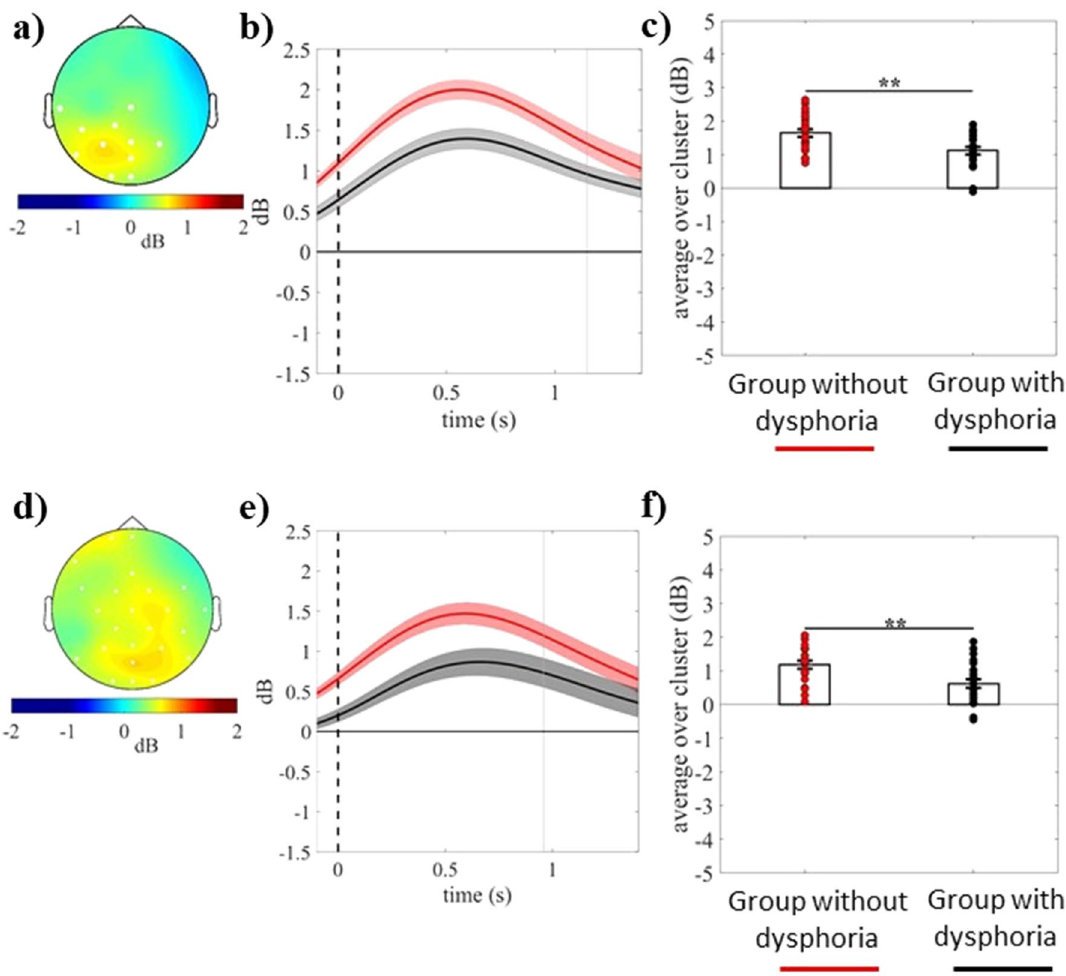
Figure 3. ( a , d ) Topography of the mean difference between groups in event-related delta power (dB; group without dysphoria minus group with dysphoria) averaged over the significant time points ( a ; − 100 to1148 ms time window) for the pleasant and ( d ; − 100 to 958 ms time window) neutral condition, respectively. ( b ) Time course of grand-average event-related delta power averaged over the significant electrodes for pleasant and neutral conditions in the group with dysphoria (black line) and the group without dysphoria (red line). Shaded areas represent ± standard error of the mean (SEM); the gray line represents the end of significant time windows. ( c ) Mean event-related delta power of each participant in the group with dysphoria and the group without dysphoria averaged over the significant electrodes and time points for the pleasant condition and ( f ) neutral condition. Each circle represents one participant; the frames represent the mean event-related delta power across all participants in the group with dysphoria and the group without dysphoria and the solid black lines represent ± SEM. ** p <